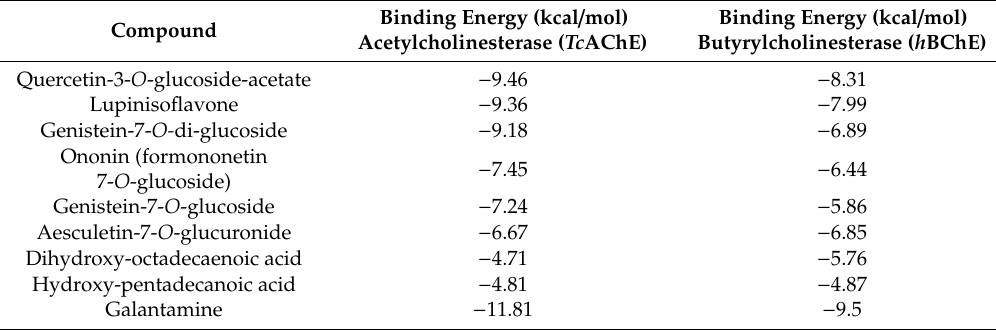
Table 4. Binding energies obtained from docking experiments of most abundant compounds in G. sphacelata ’s fruit and the known cholinesterase inhibitor galantamine over acetylcholinesterase ( Tc AChE) and butyrylcholinesterase ( h